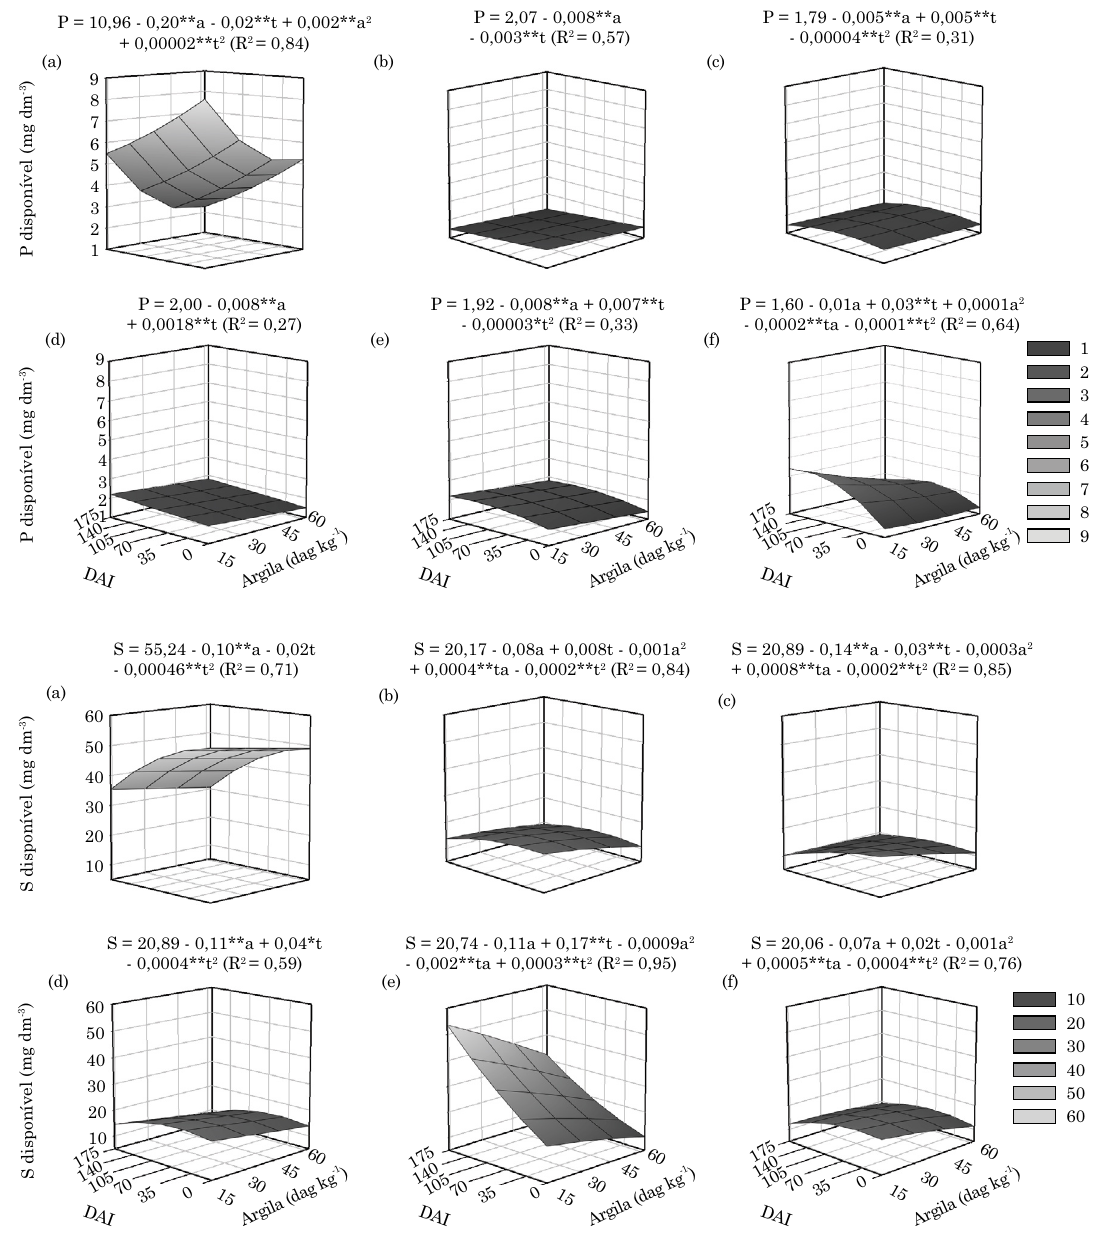
figura 4. teores disponíveis de p (mehlich-1) e s (fosfato de cálcio em ácido acético) nos solos com fontes inorgânicas dos nutrientes (a), sem adição de nutrientes e resíduo (b); e com resíduo de: milho (c), braquiária (d), feijão (e) e estilosantes (f). * e **: significativos a 5 e 1 %, respectivamente, referentes às variáveis: a – teor de argila, t – tempo e ta – interação entre esses. DAI: dias após o início da